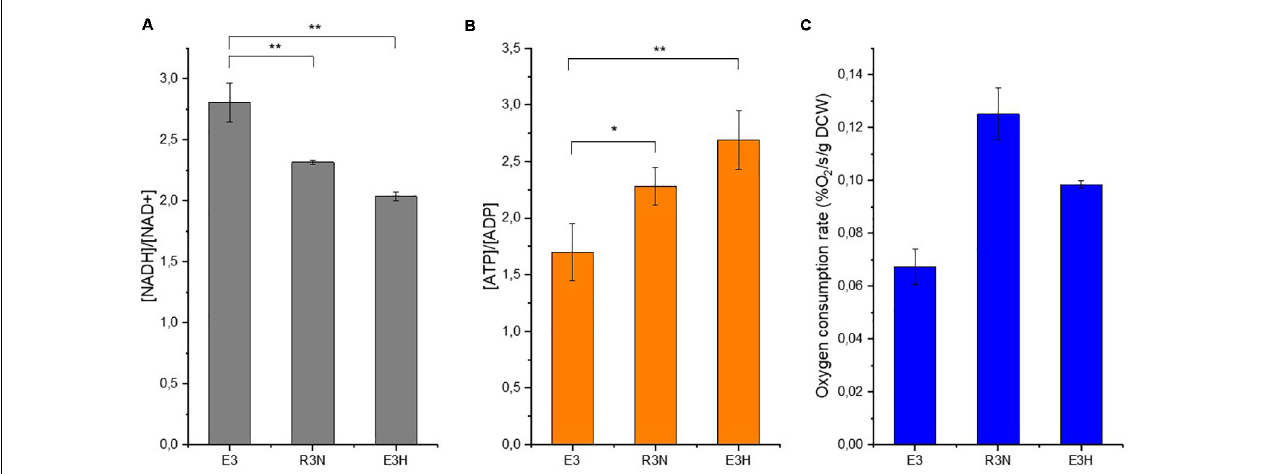
FIGURE 6 | Intracellular cofactor ratios, [NADH]/[NAD + ] (A) and [ATP]/[ADP] (B) , oxygen consumption rate at the same time (C) in E3, R3N and E3:F1F0ATPase (E3H). Data are shown as mean ± standard deviation from three independent experiments. Asterisks indicate the significance of variance. *, P -value < 0.05; **, P -value <